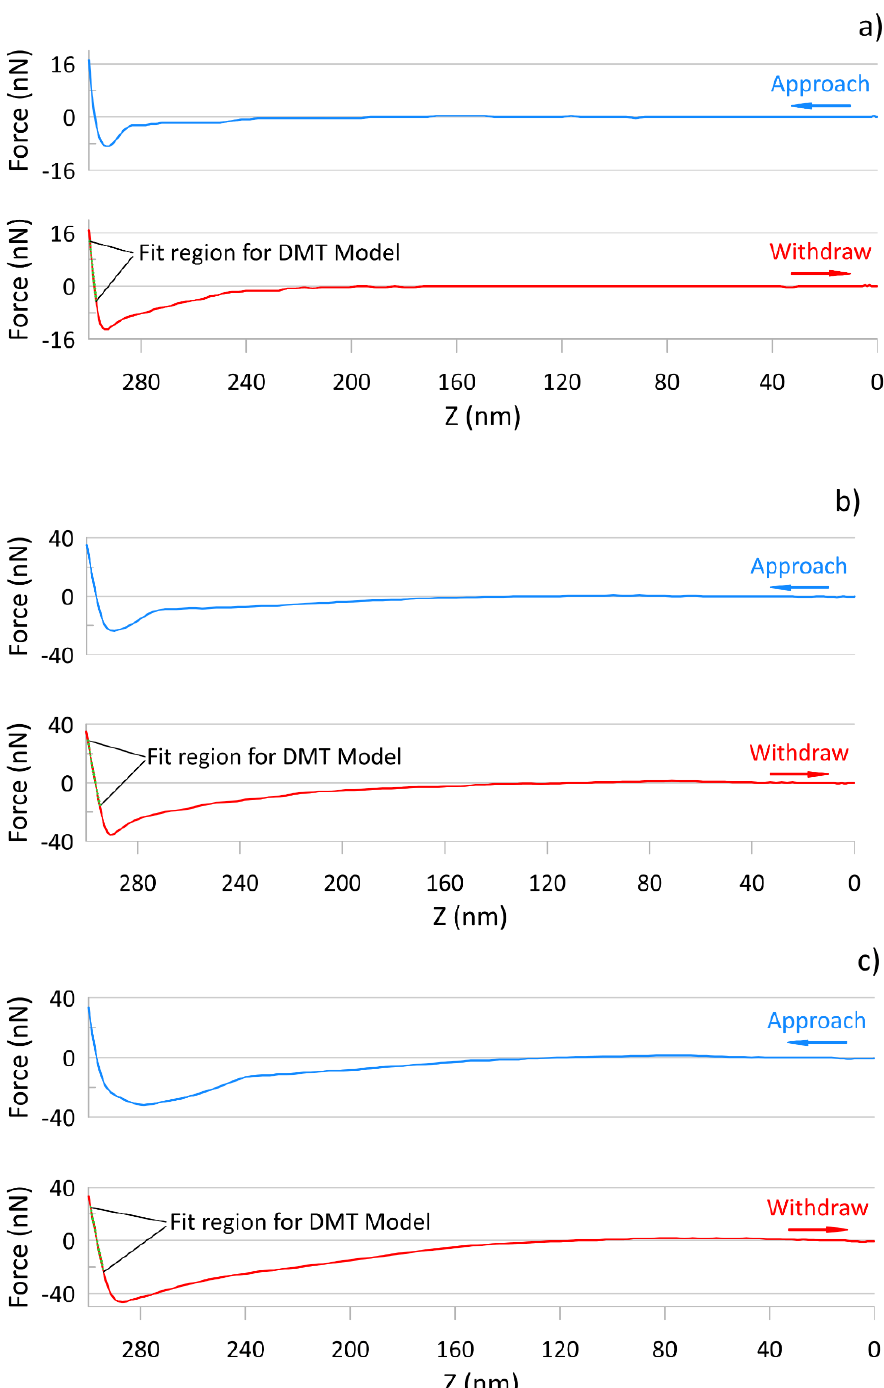
Figure 2. Typical force curves for samples k0 ( a ), k5 ( b ), k10 ( c ), with marked fitting regions for the DMT model.